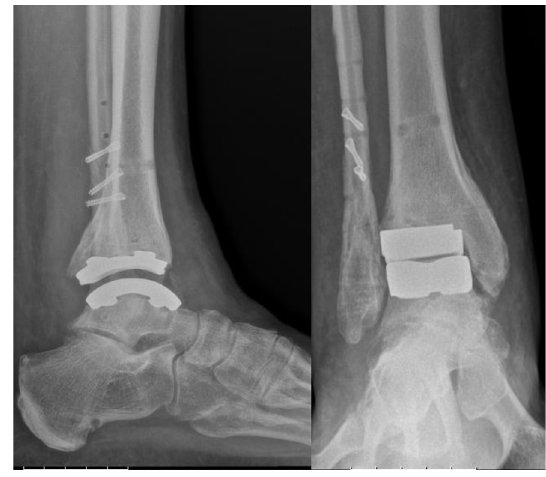
Figure 5. Lateral and antero-posterior view of the weight-bearing control radiographs.